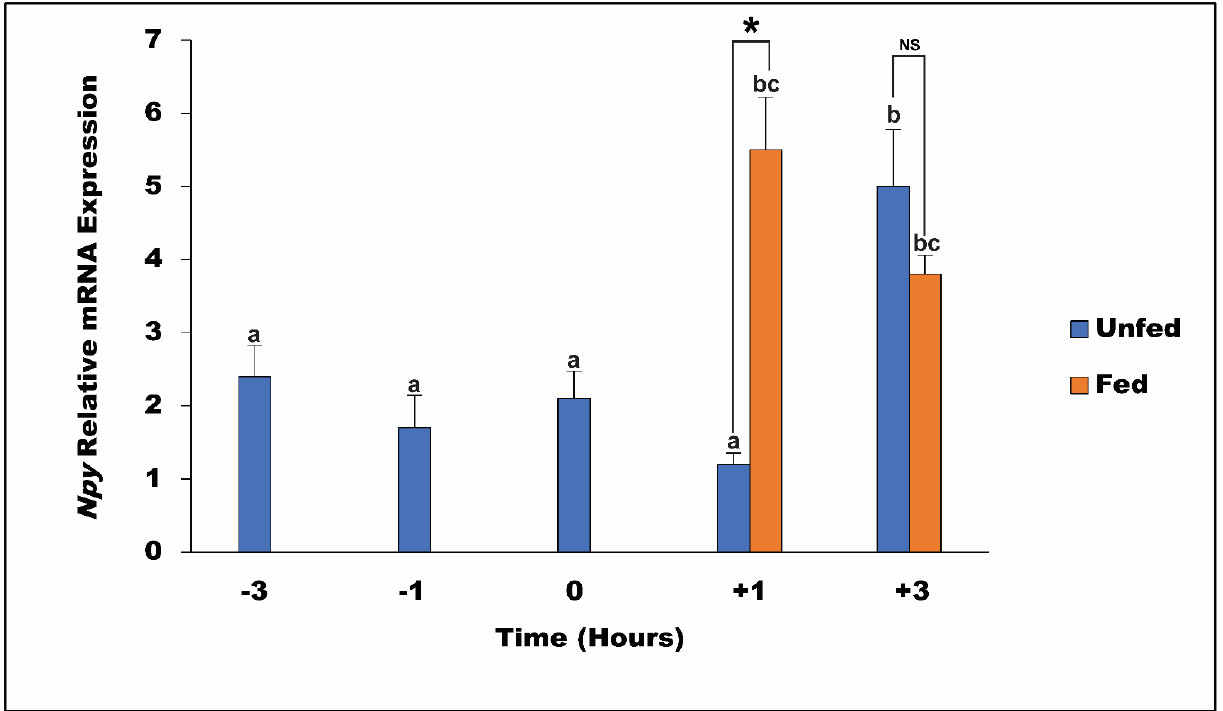
Figure 5. Pre- and Post-prandial effects on npy mRNA levels in the hypothalamus of Scatophagus argus . Bars with different letters represent significant differences between experimental groups, while the asterisk represents the significant difference between groups at a specific time (* p < 0.05). NS means non-significant.